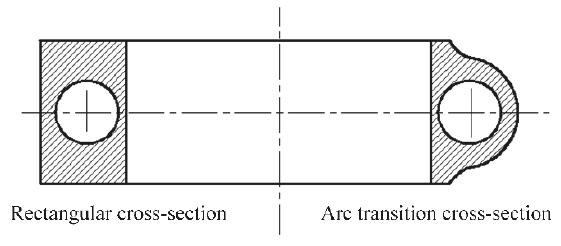
Figure 12. Cross-section design.